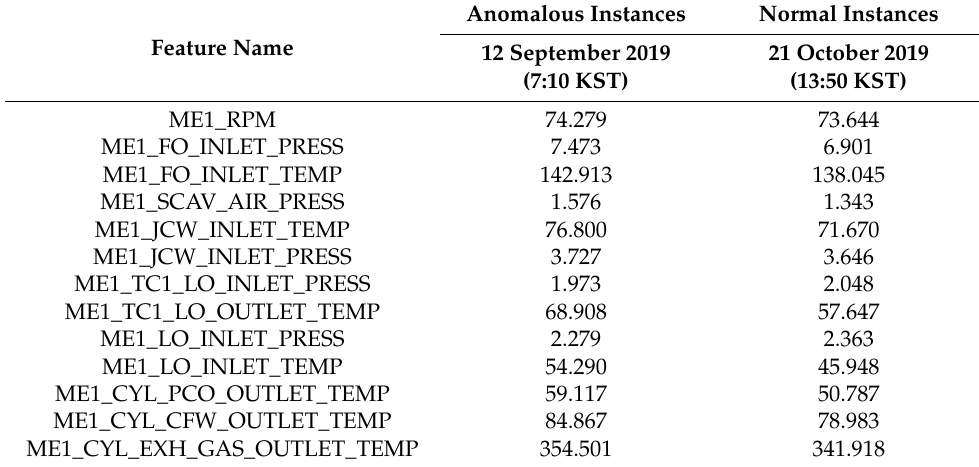
Table 3. Comparison of actual values between two data instances in Figure